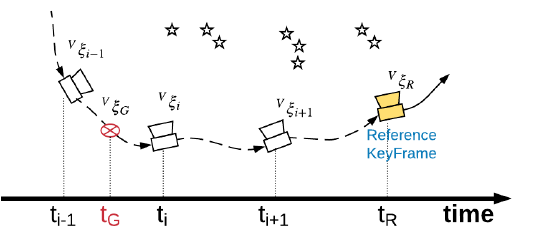
Figure 4. The interpolation of Global Navigation Satellite System (GNSS) positions in a visual navigation